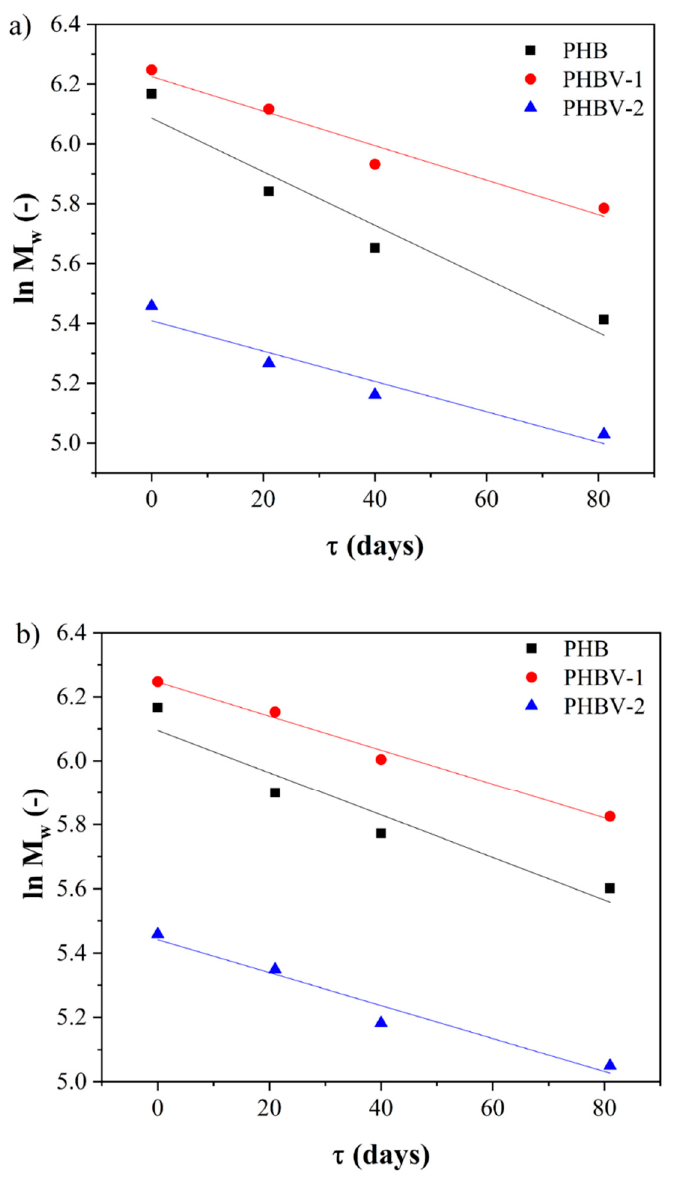
Figure 8. A linearized model of first-order kinetics applied on the degradation of PHB, PHBV-1, and PHBV-2 in ( a ) synthetic gastric solution and ( b ) phosphate buffer saline solution with lipase. Table 7. Kinetic model parameters and coefficients of determinations (R2) for the degradation of PHB, PHBV-1, and PHBV-2 in model fluids at 37 °C.